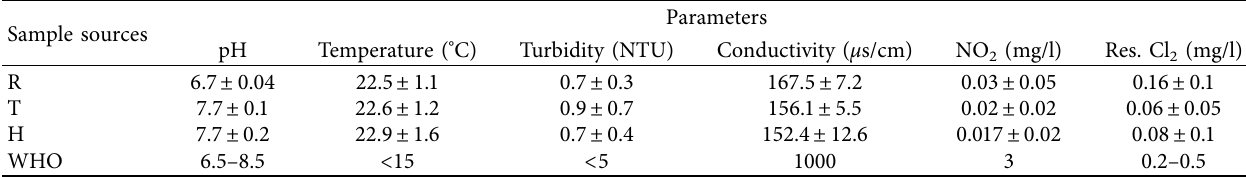
Table 2: Mean ( n � 30) physicochemical values of drinking water samples from the reservoir, taps, and households’ containers in Addis Kidame Town,